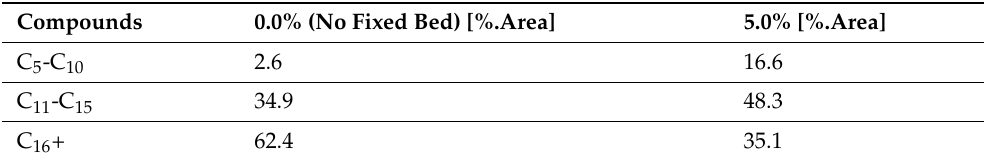
Table 10. Carbon chain length distribution of liquid bio-oil obtained through thermal cracking and catalytic upgrading with 5.0% red mud pellets fixed bed, reaction time of 20 min.